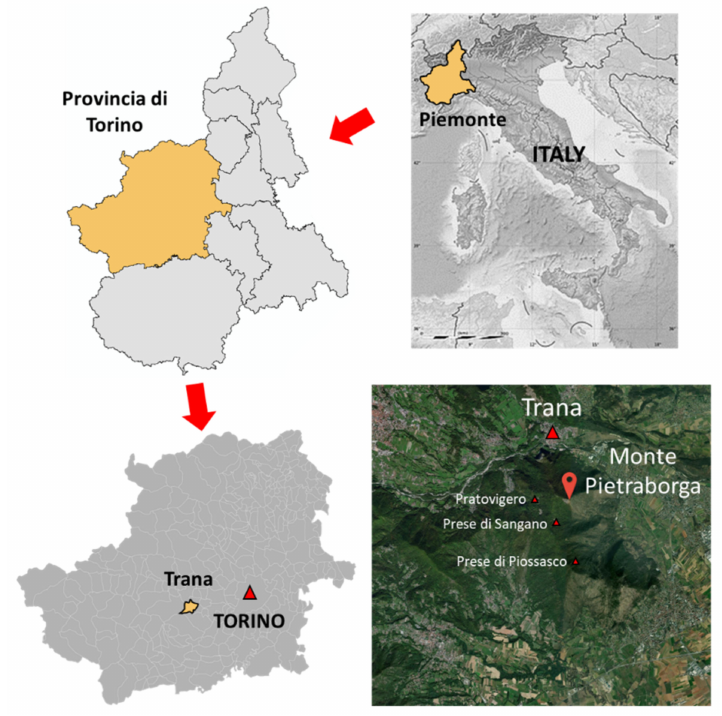
Figure 1. Monte Pietraborga location (Trana, Provincia di Torino, Piemonte,